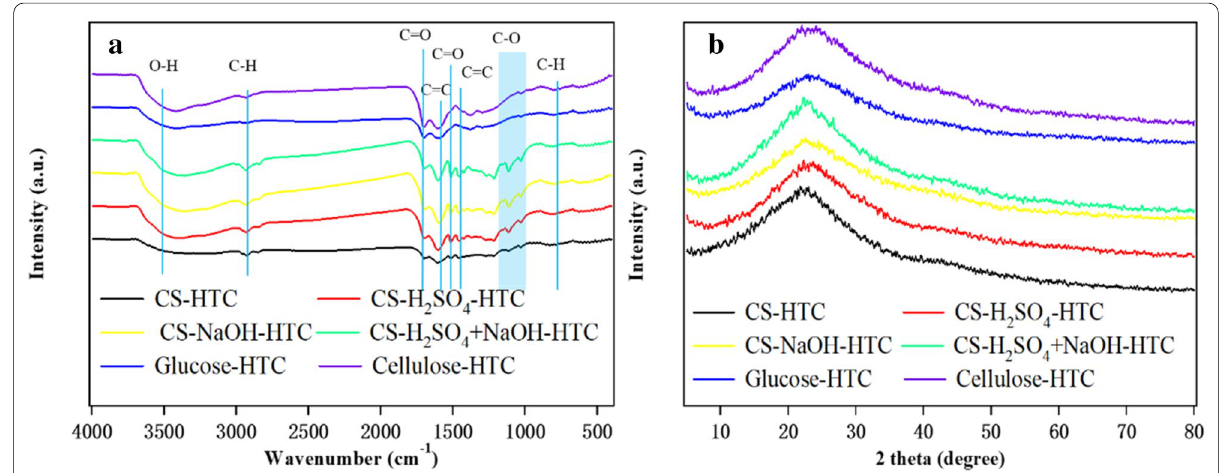
Fig. 4 FTIR spectra ( a ) and XRD patterns ( b ) of CS hydeochars, glucose and cellulose-derived